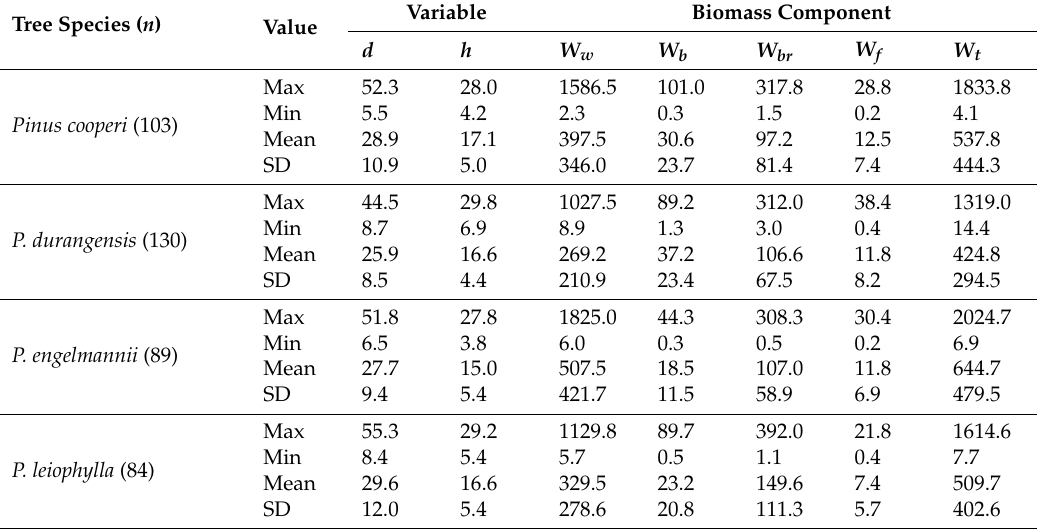
Table 1. Summary statistics of the felled trees and the main above-ground biomass components used to develop the biomass equations in the